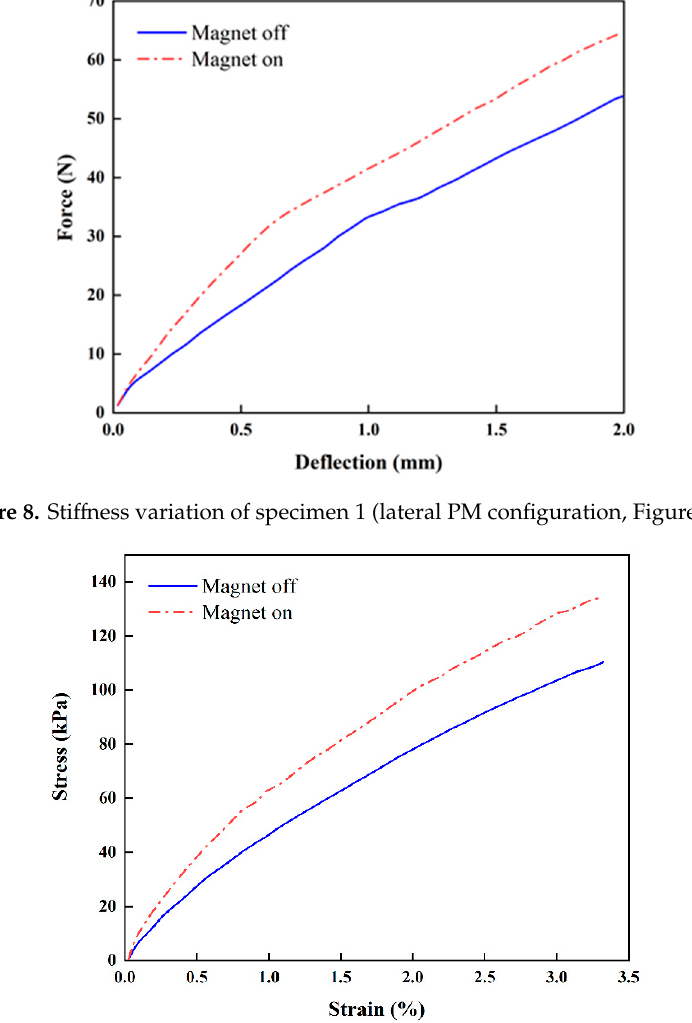
Figure 9. Stress-strain curve of specimen 1 (lateral PM configuration, Figure 6c).